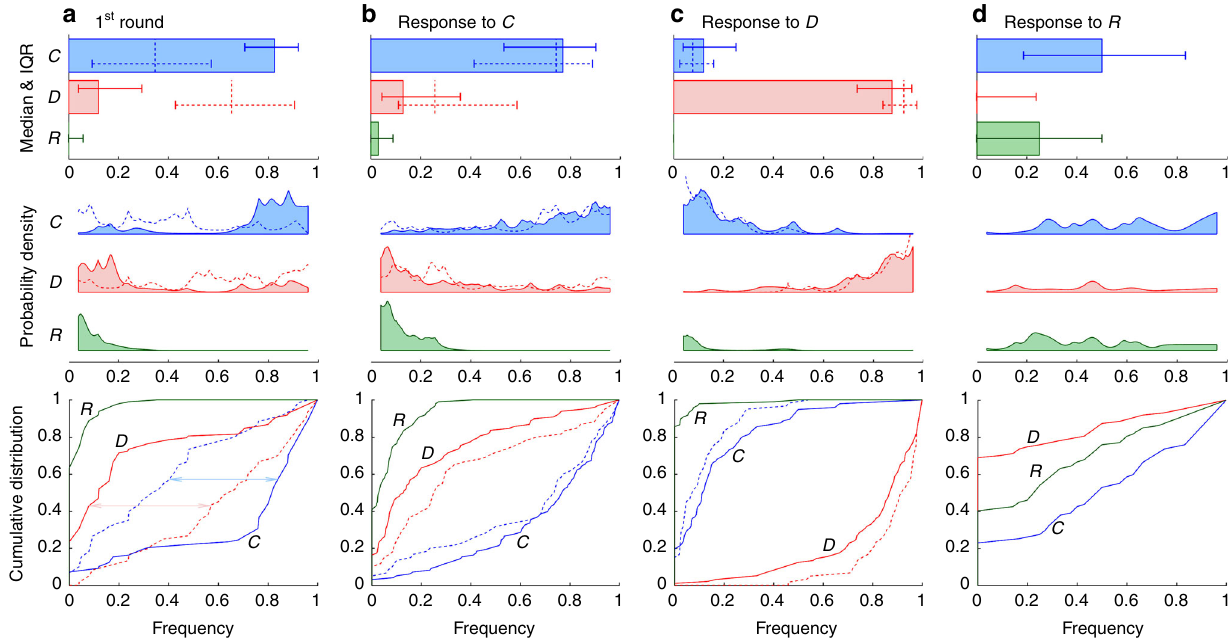
Fig. 3 As a cooperation promoter, reward is effective even before it can be used. a Median frequency of cooperation C in the fi rst round of the decoy treatment (bars) is considerably higher than in the control treatment (dashed lines): 82.4% vs. 34.7%, respectively. The opposite is true of defection D : 12.0% vs. 65.3%, respectively. Volunteers in the decoy treatment also appear to be more decisive than in the control treatment as hinted by a much narrower interquartile range: e.g., for C : 21.4% vs. 47.6%, respectively. Action frequencies were calculated as in Fig. 1. Probability densities show